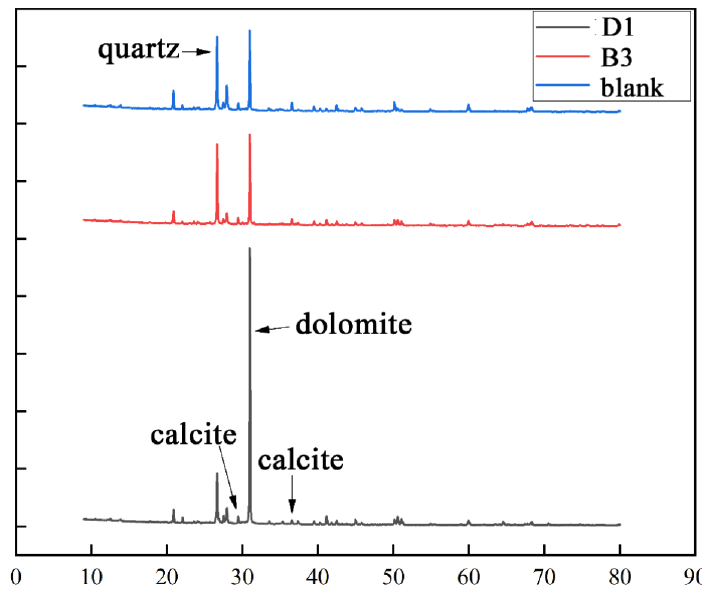
Figure 14. XRD pattern of the sample. Table 3. Analysis results of various substances in MICP-treated